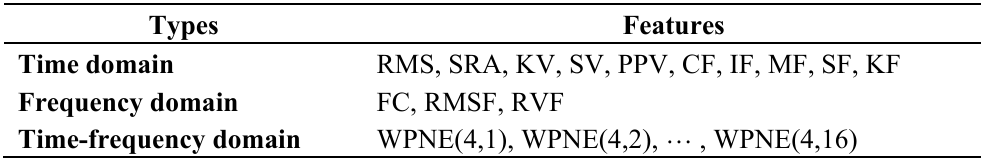
Table 1. The 29 initial features from vibration